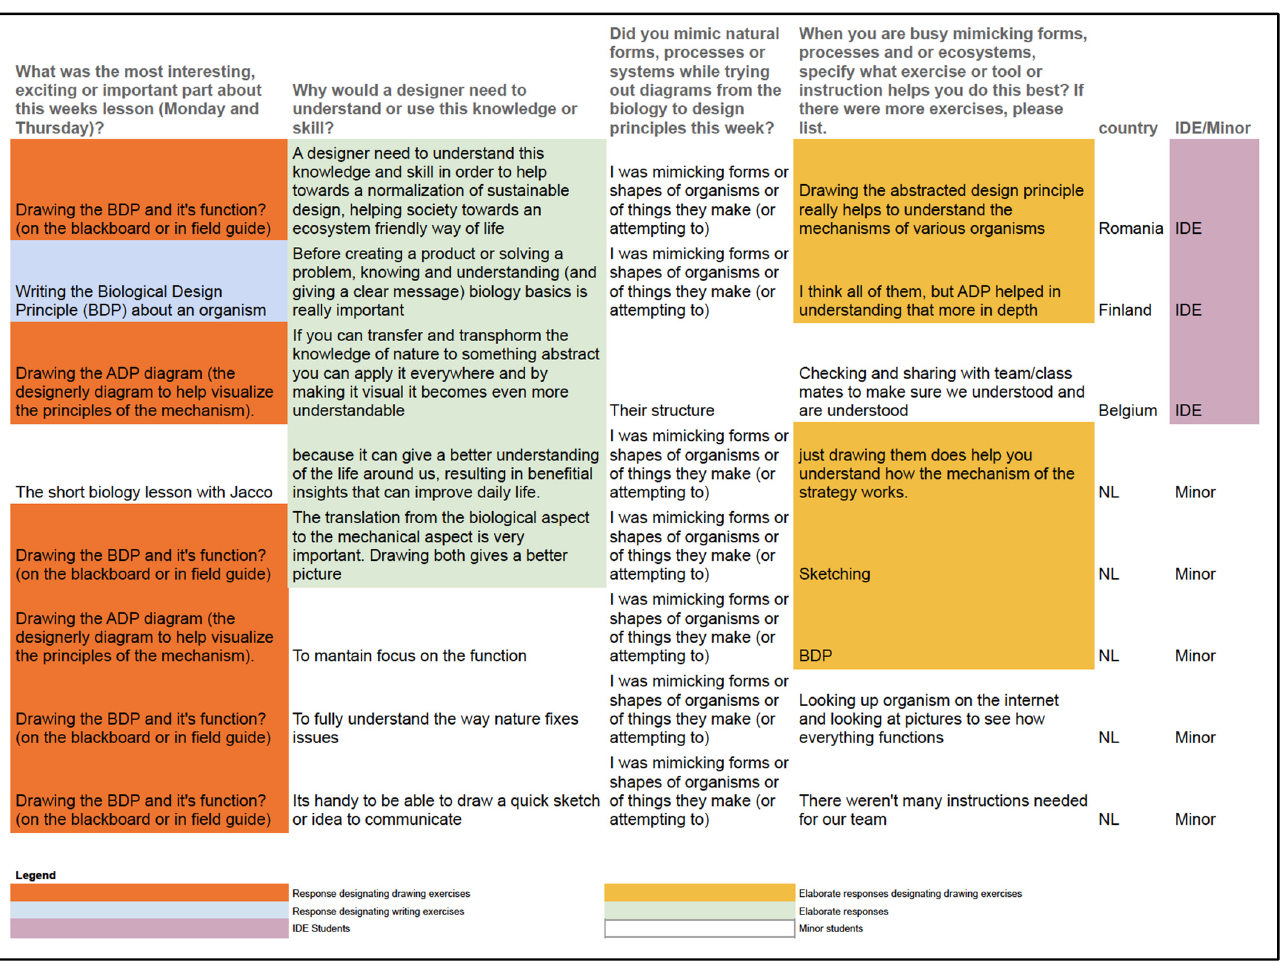
Figure 9. Interview responses of the student cohort mimicking form in their designs. (2) Eight of the eleven students who mimicked the process stated that a written exer- cise (writing the ADP or NTS) was most interesting, exciting or important. (Figure 10);